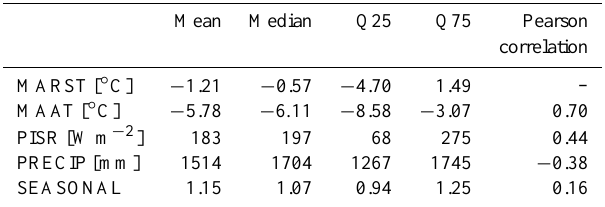
Table 4. Summary statistics and Pearson correlations between MARST and potential explanatory variables for all MARST loca- tions for the rock model (Q25 lower quantile, Q75 upper